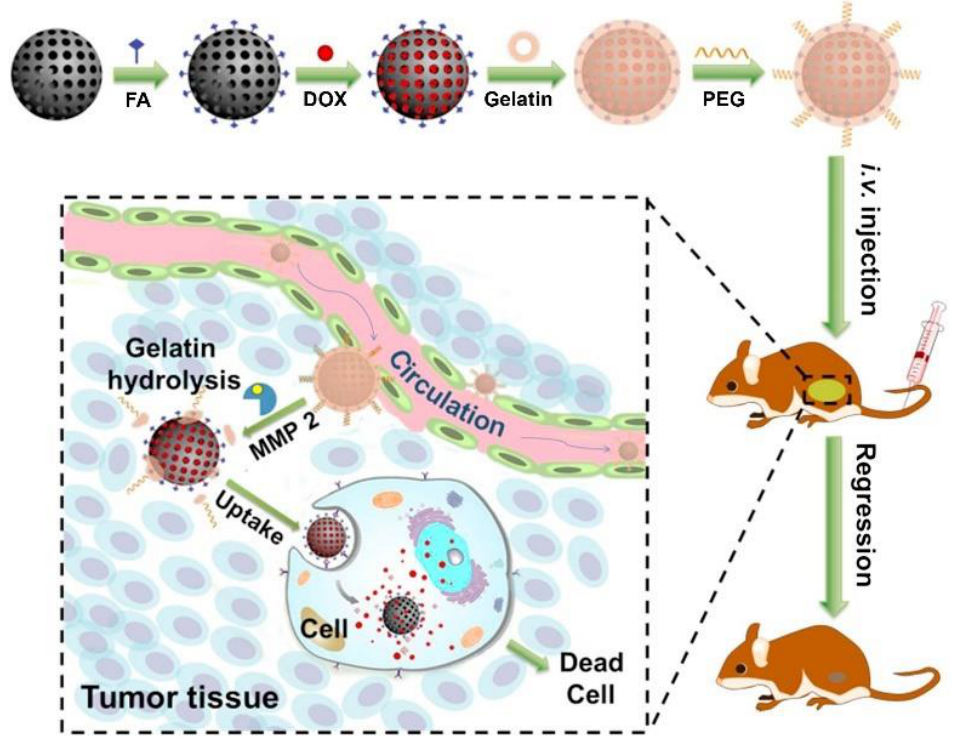
Figure 10. Schematic illustration for the formulation of multifunctional drug-loaded PGMSN and MMP 2-triggered targeting and drug delivery strategy of PGFMSN. Reproduced with permission from ref. [103]. Copyright 2015, Elsevier Ltd.